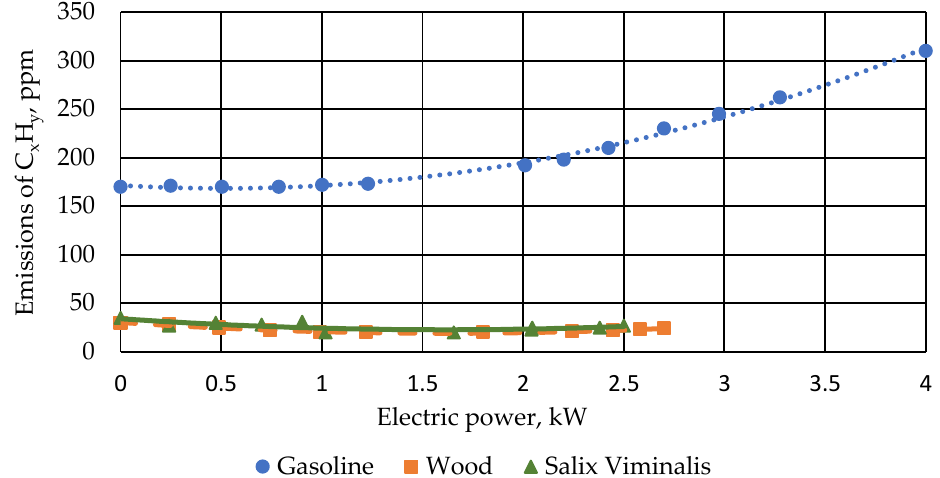
Figure 9. Emissions of CO.